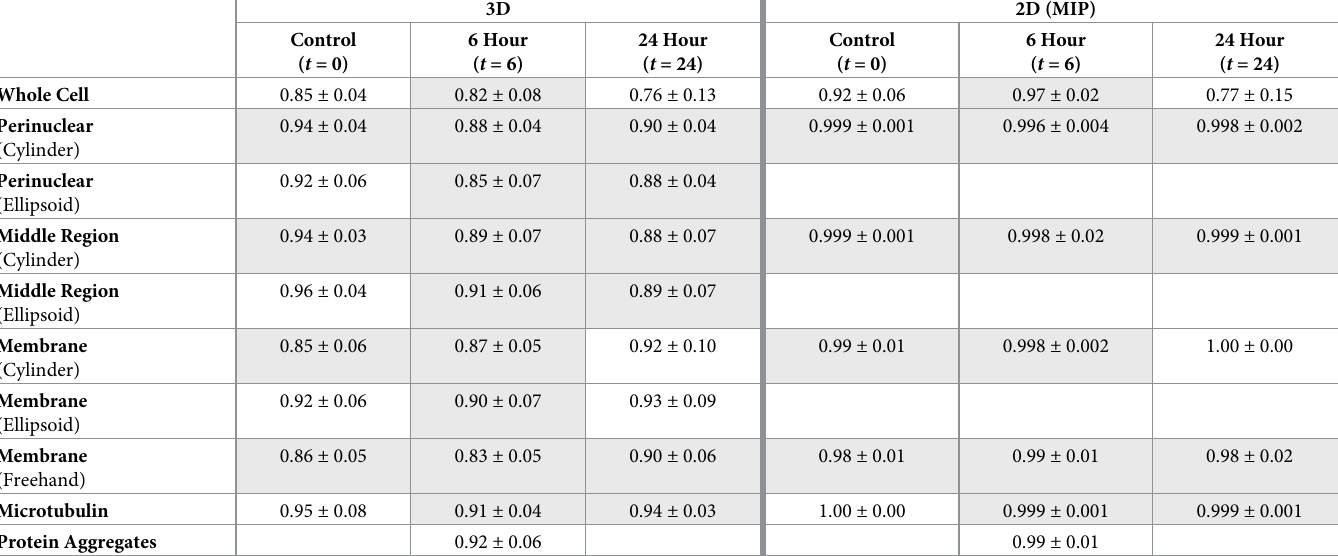
Table 5. Manders’ correlation coefficient for acetylated α -tubulin (M2) with procedure described in Table